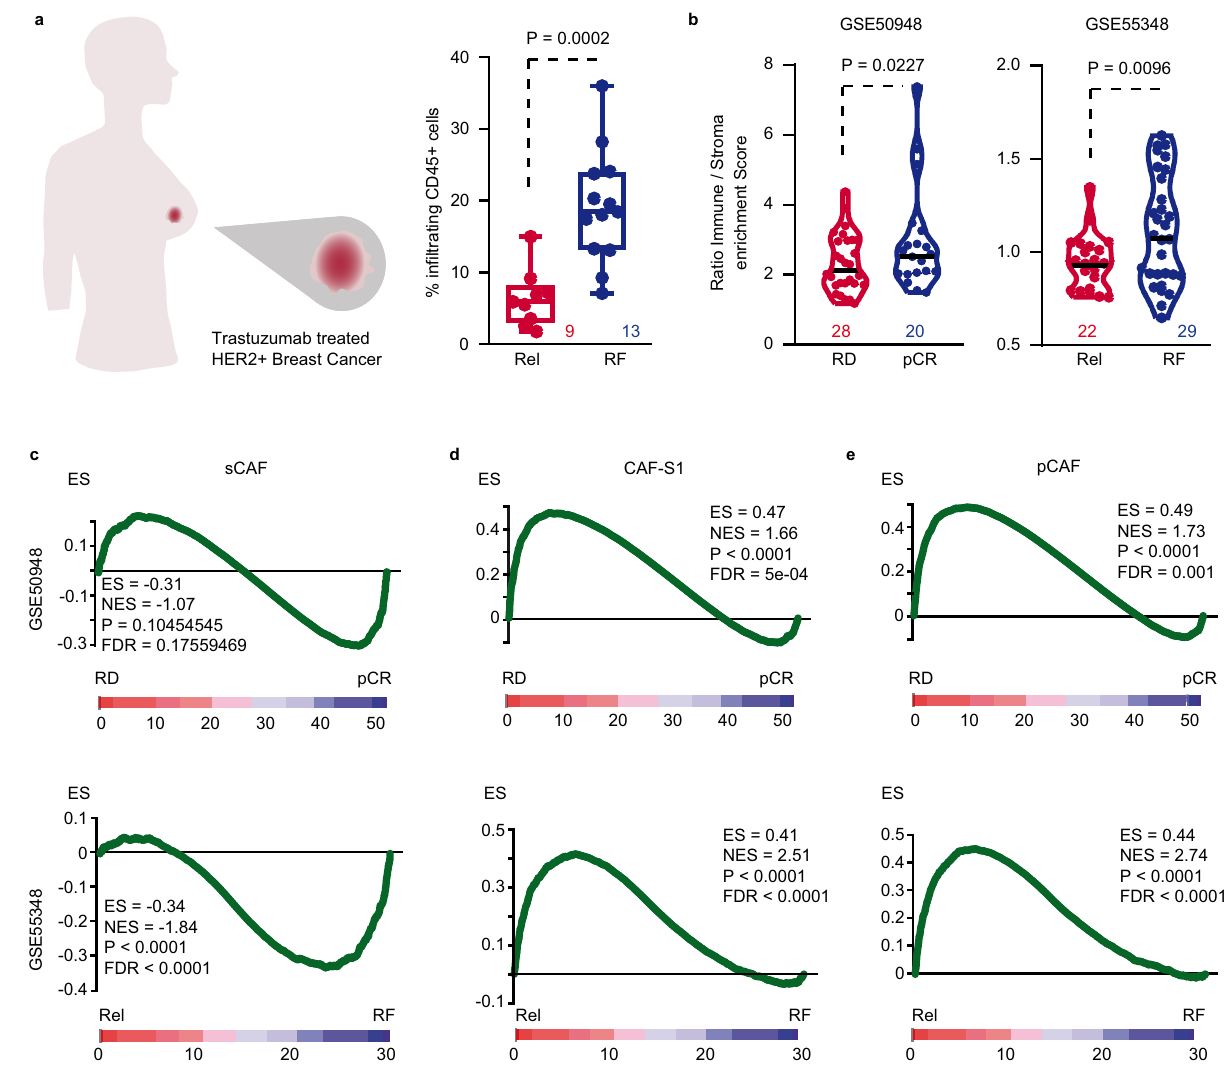
Fig. 1 | Stromal traits de fi ne resistance to trastuzumab. a Percentage of CD45+ cells in HER2+ BC tumors comparing relapse-free (blue) to relapsing patients (red) after trastuzumab-based therapy. Central mark indicates the median, box extends from the 25 to 75th percentiles, whiskers represent the maximum and minimum datapoint.Numberofpatientsineachgroupisindicated. b Violinplotsofimmune/ stromaenrichmentscoreratioforpatientswithpCR(blue)vs.RD(red)(GSE50948) and for relapsing (red) vs. relapse-free patients (blue) (GSE55348). Number of patients in each group is indicated. c – e Gene-set enrichment analyses (GSEA) in